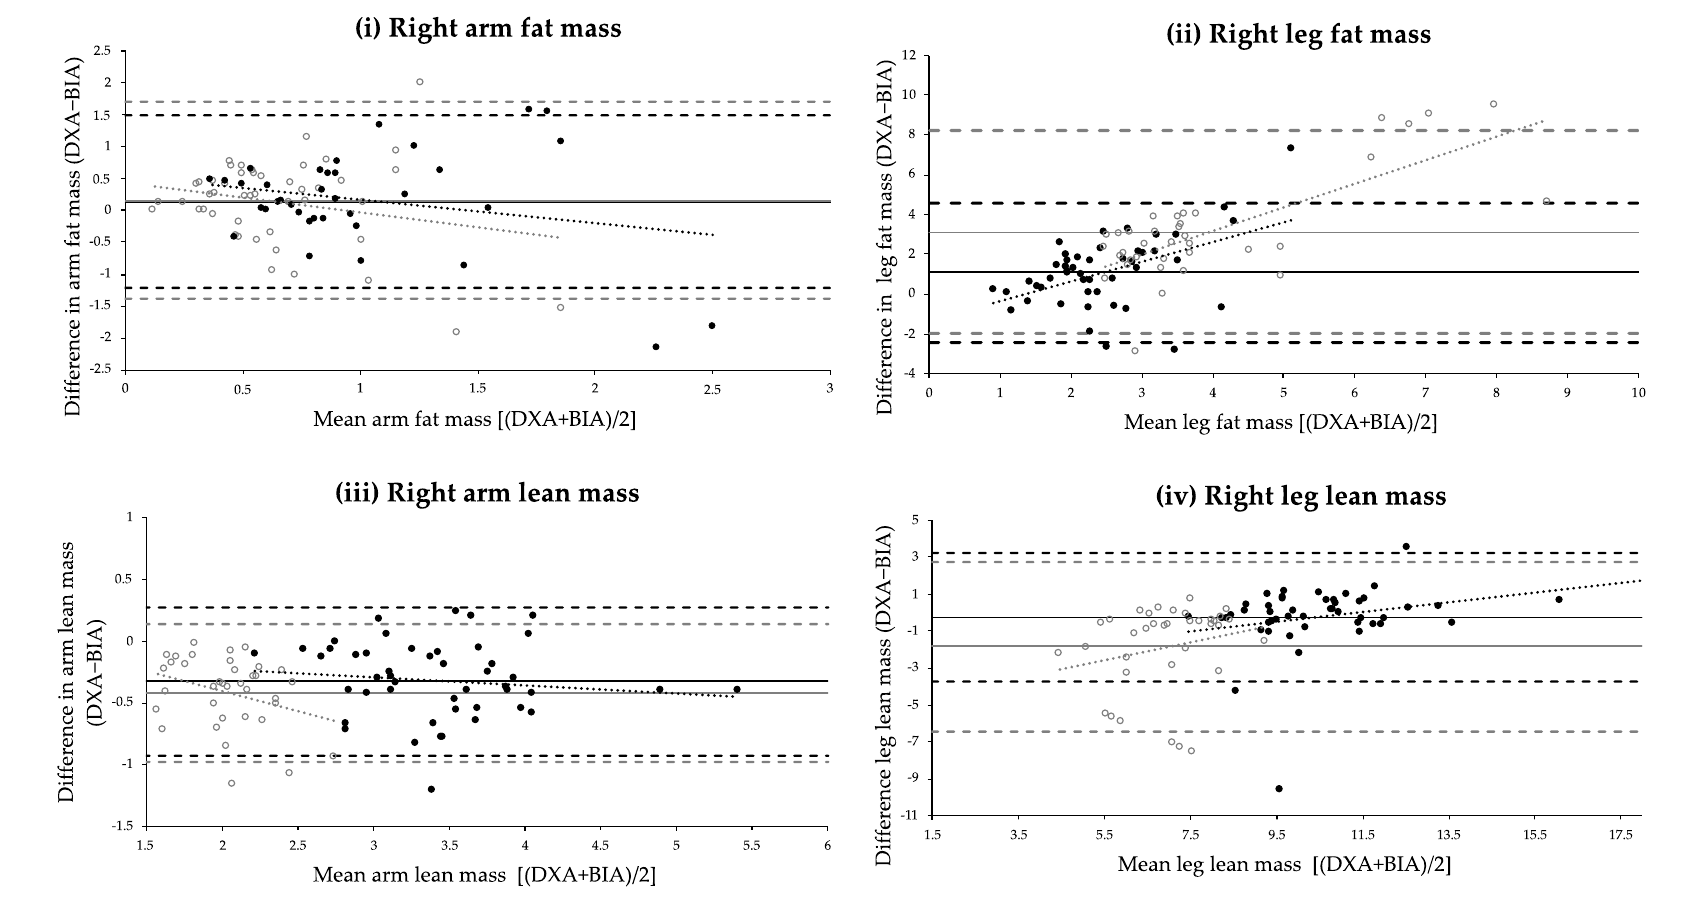
Figure 2. Bland–Altman plots showing the mean value plotted against the mean difference (DXA vs. BIA) for segmental outcome measures.